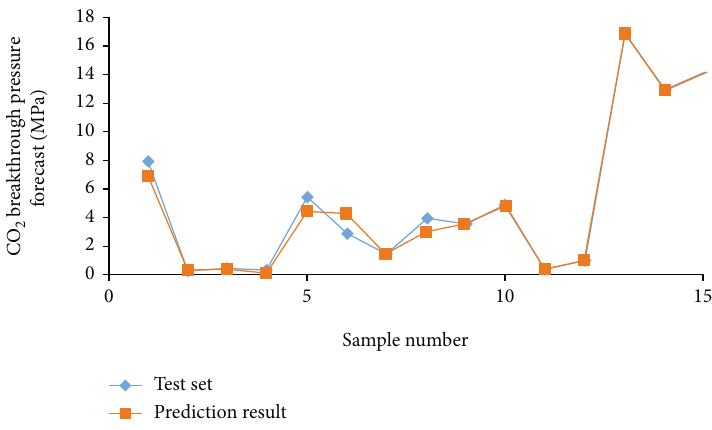
Figure 15: Comparison of the test set and prediction result.